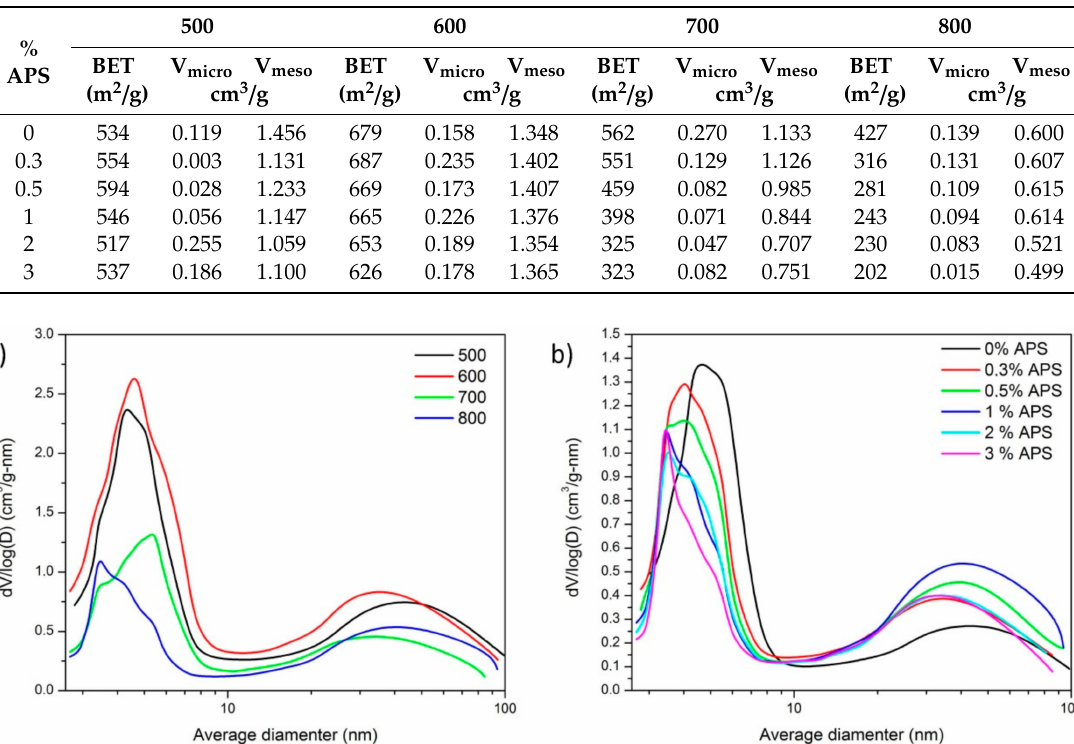
Table 3. Specific surface area (as determined by BET), micropore (as determined by the t-plot method) and mesopore volumen (determined from BJH method) of the prepared materials loaded with the maximum amount of TFV.